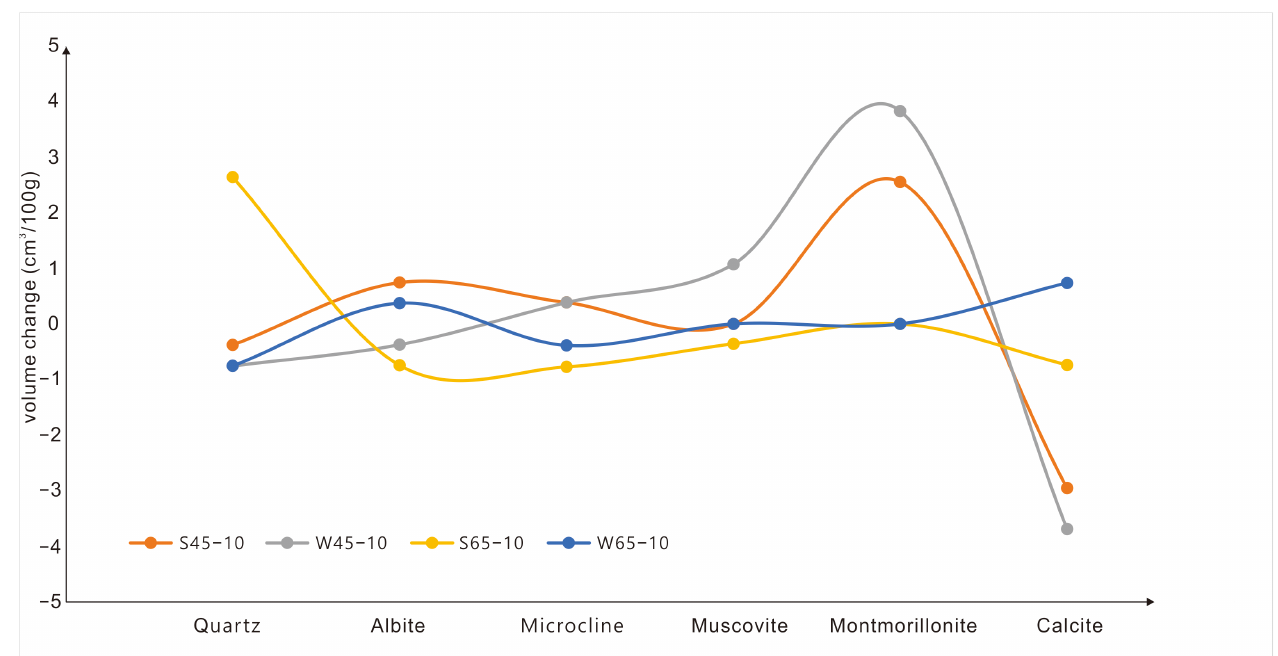
Figure 10. Characteristics of volume change of individual minerals under different temperature